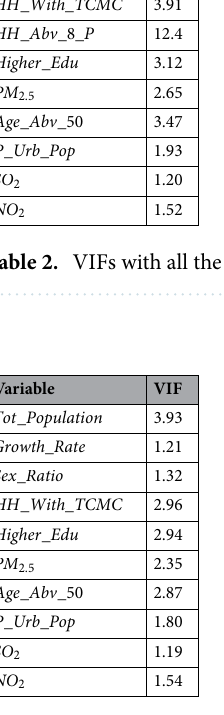
Table 3. VIFs after removing the variable HH _ Abv _8_ P